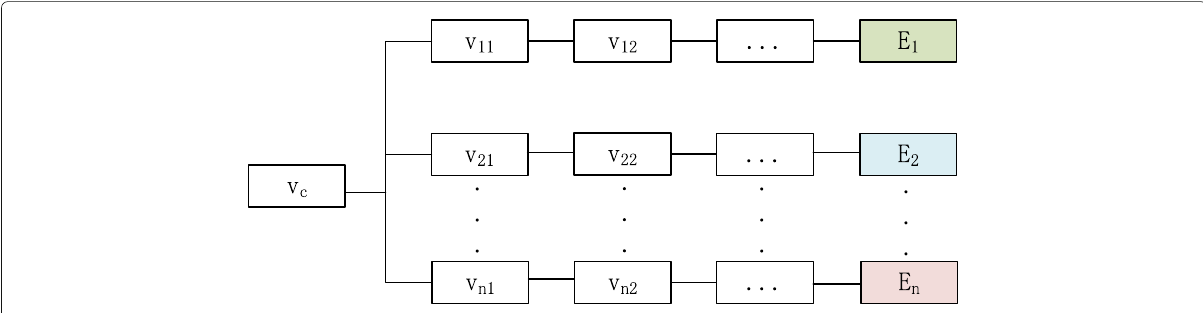
Fig. 2 Network topology in a vehicle-mounted ad hoc